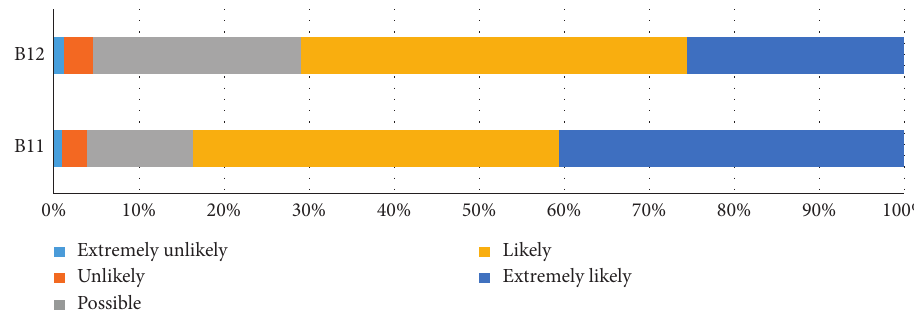
Figure 5: Percentage of behavior intention to use Robo-taxis.